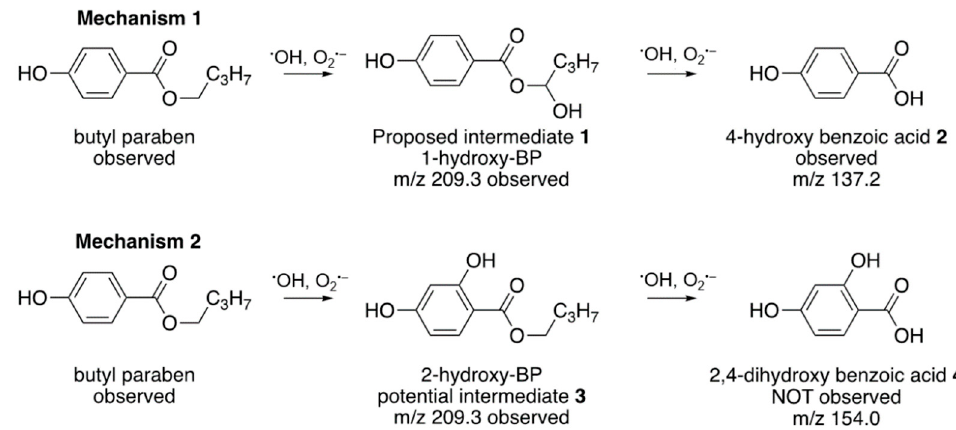
Figure 9. Proposed reaction pathways for the catalytic ozonation of butyl paraben.